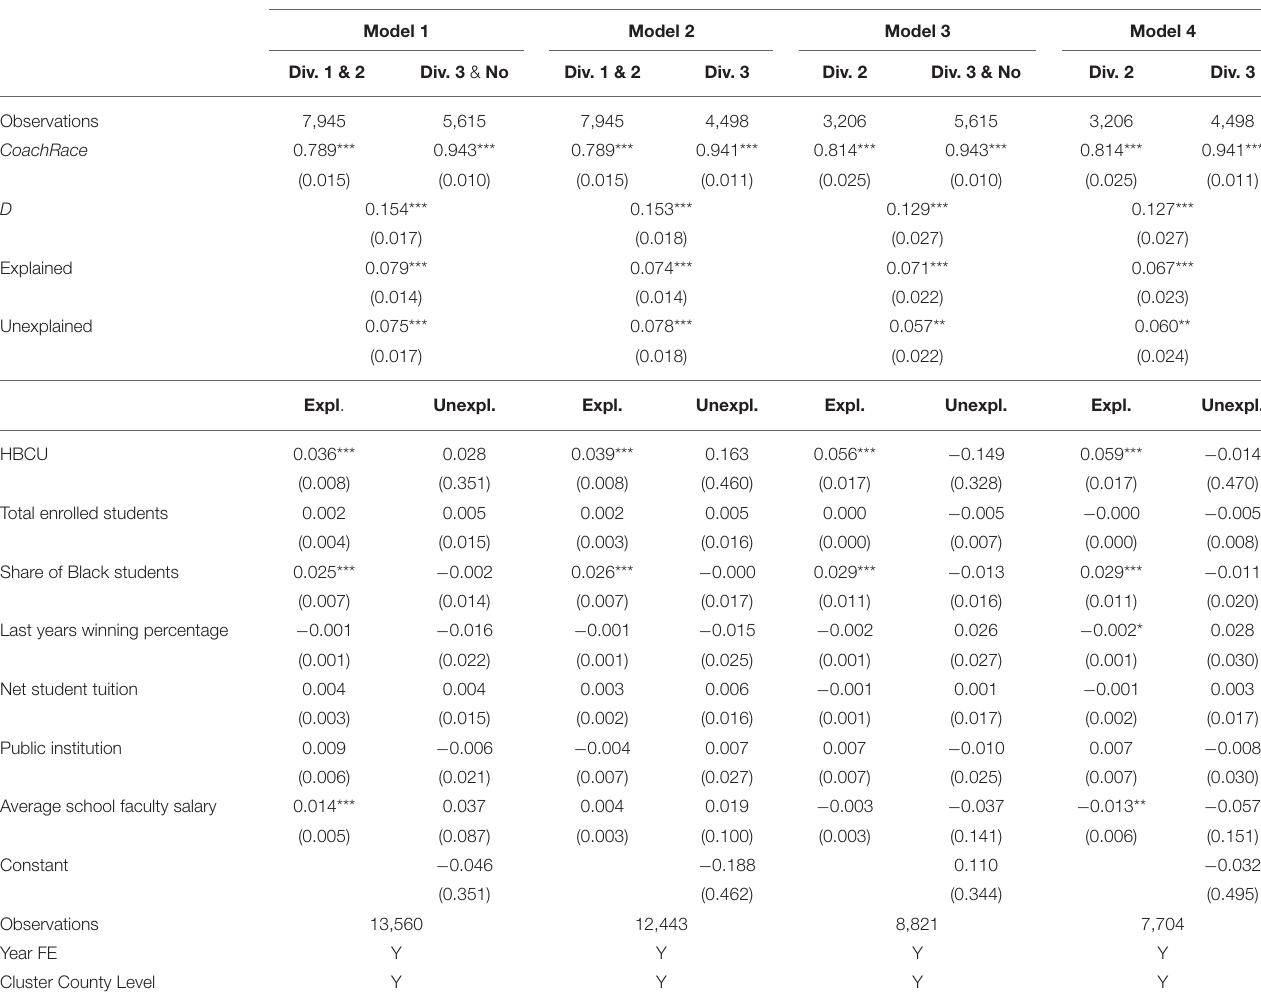
TABLE 3 | Model results (OLS).